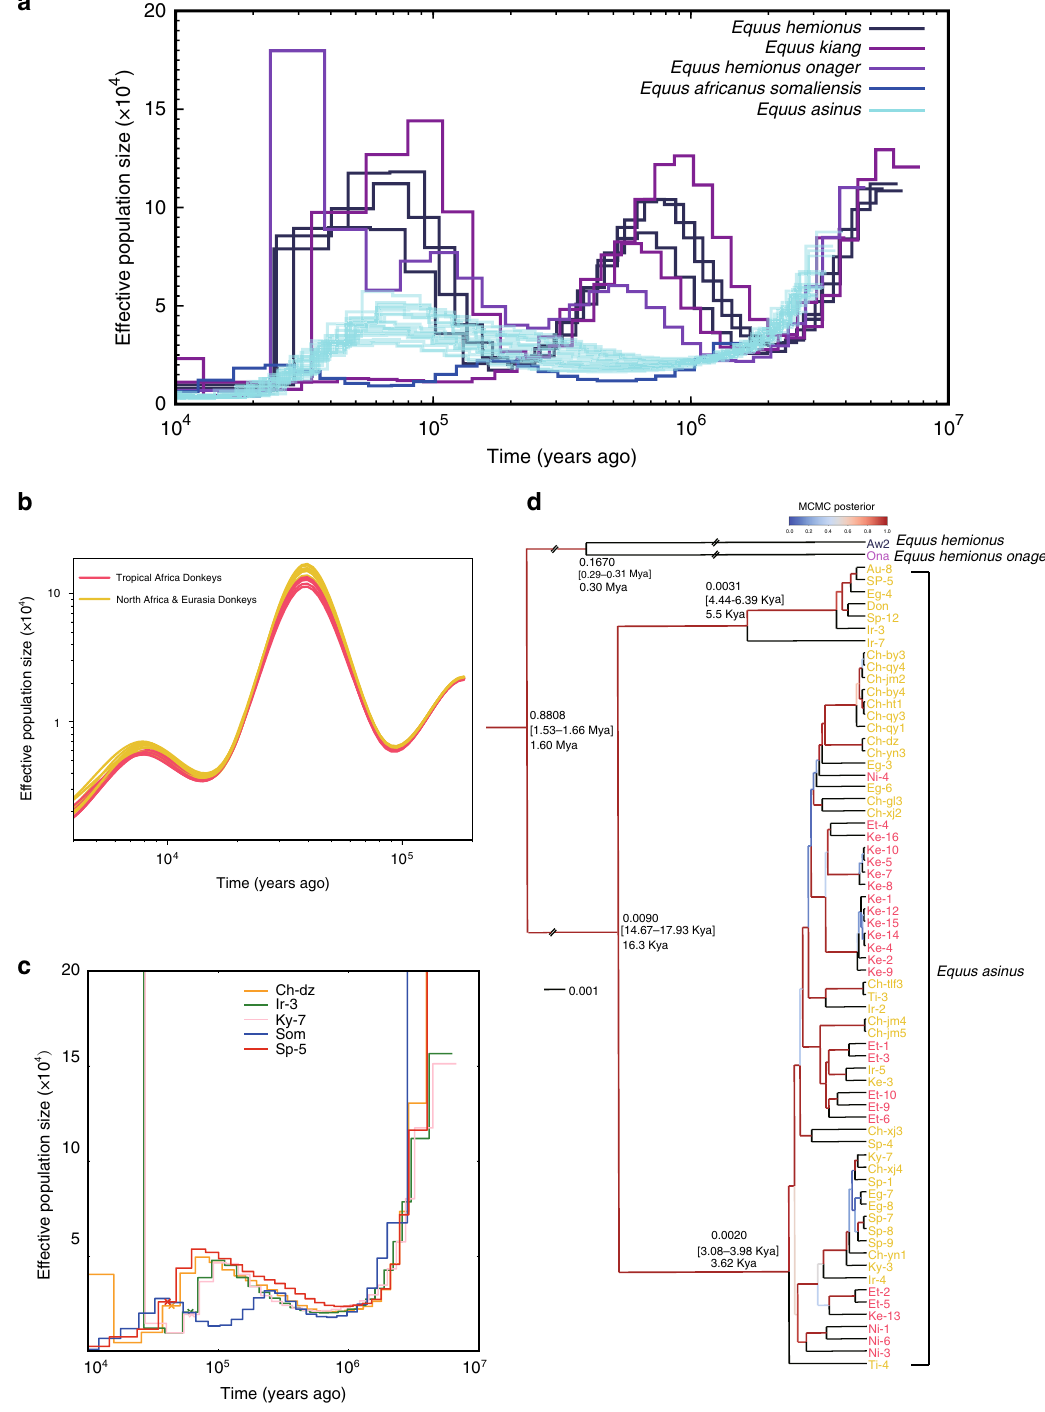
(diluted hairs). This result is consistent with observations made by Imsland et al. 25 in horses. Histological sections of croup skin indicated that in Dun donkeys, pigments are densely distributed on the outward side of the hair follicle and sparsely distributed on the inward side. In contrast, in non-Dun donkeys, pigments are evenly distributed on both sides of the hair follicle (Fig. 4b). Histological sections of anagen hair follicles revealed that in Dun donkeys, the uneven distribution of pigments starts in the hair